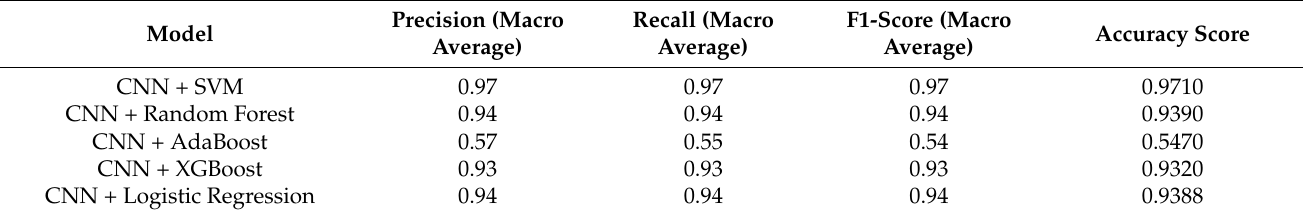
Table 9. Hybrid machine-learning models trained on the Arabic MNIST digit